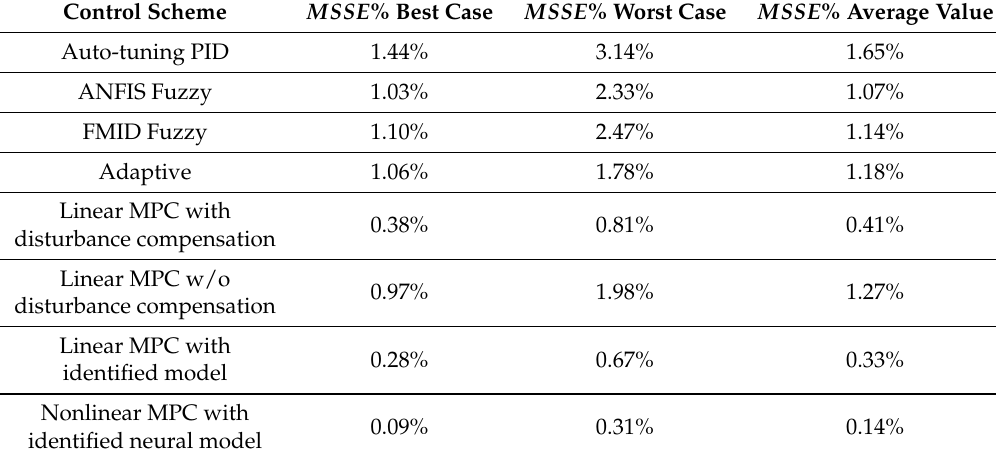
Table 3. MSSE % values obtained via the MC analysis for controller performance